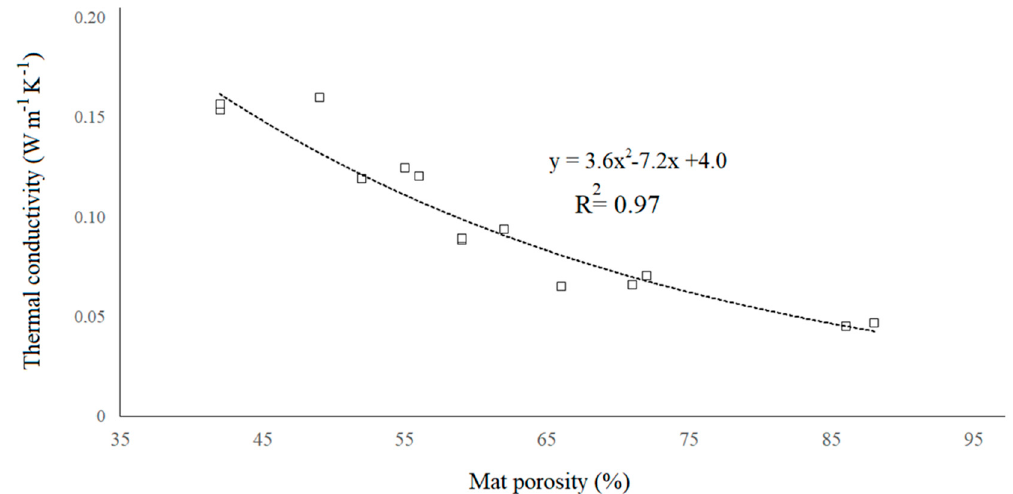
Figure 13. Effect of porosity on the thermal conductivity of the mat for all fiber sizes.